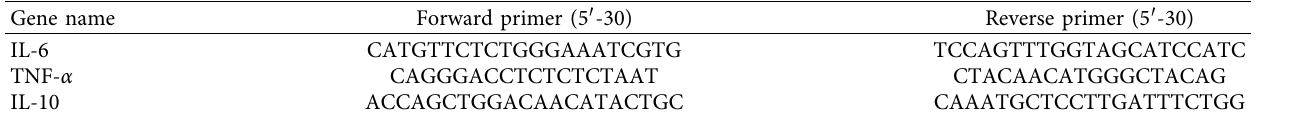
Table 1: qRT-PCR